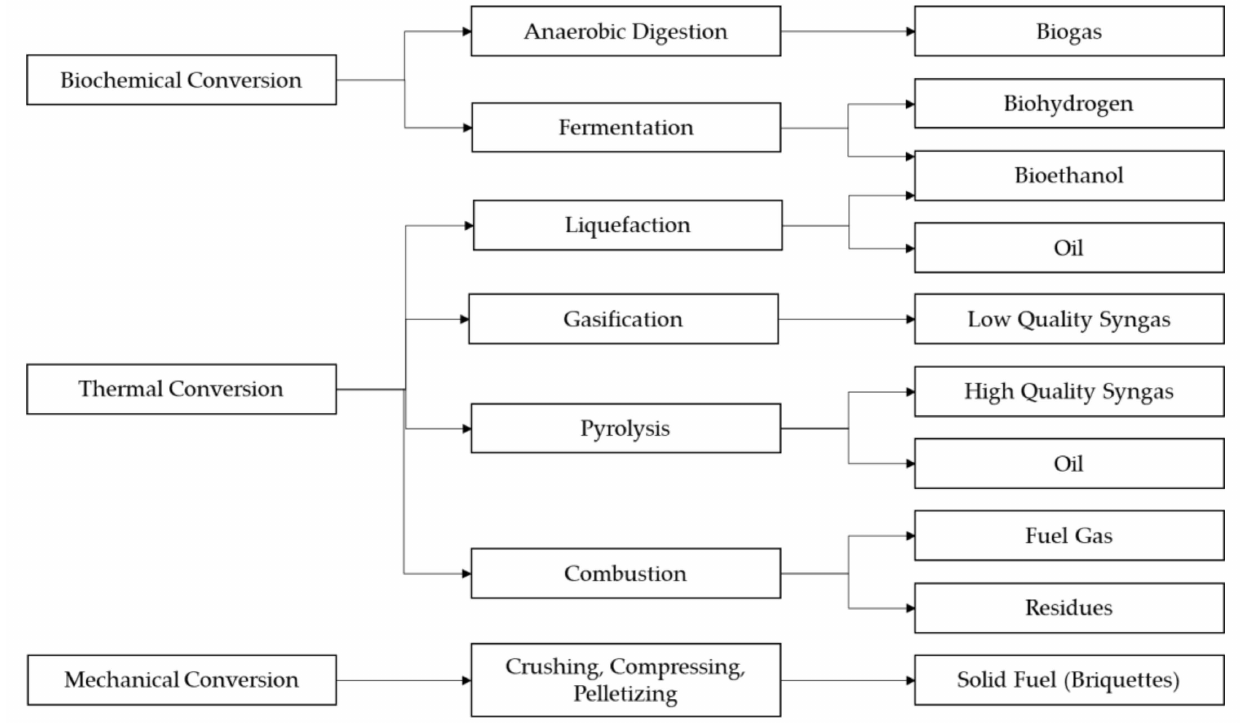
Figure 4. The energy potential of water hyacinth